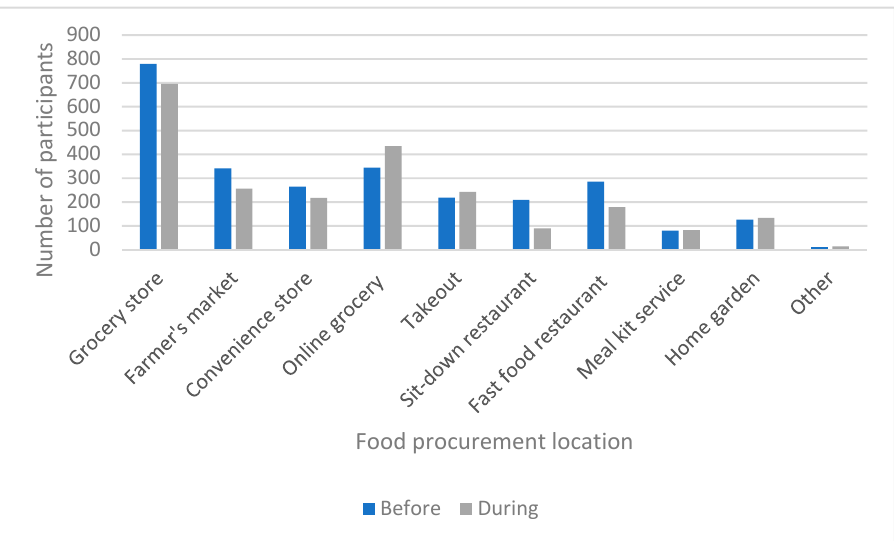
Figure 5 . Most common food procurement locations prior to and during the pandemic . Figure 5. Most common food procurement locations prior to and during the pandemic.